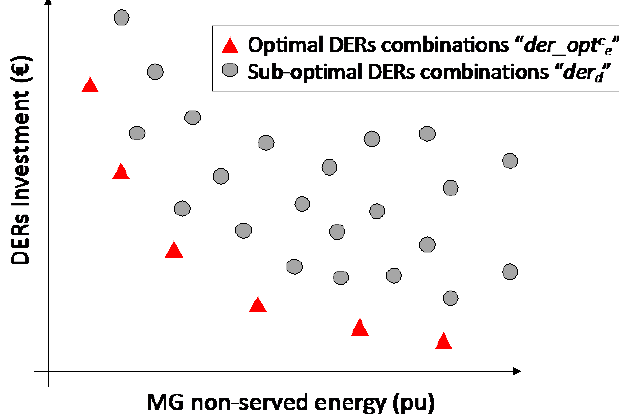
The red triangles represent the optimal subset of DER for the analyzed MG— DER_OPT c —while the grey circles represent all the rest DER combinations included in the catalog— DER set. Energies 2020 , 13 , x FOR PEER REVIEW